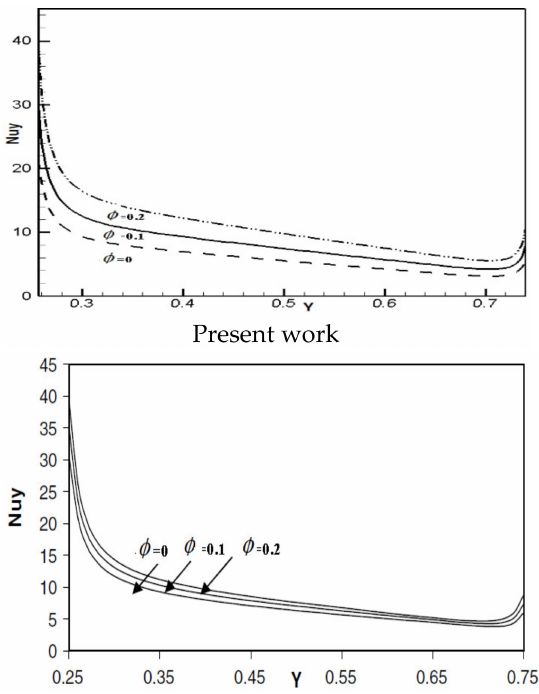
Figure 4. Variation of the left local Nusselt number variation alongside the heated left boundary (Cu-H2O nanofluid) for different volume fractions ( φ ) at Ra = 10 5